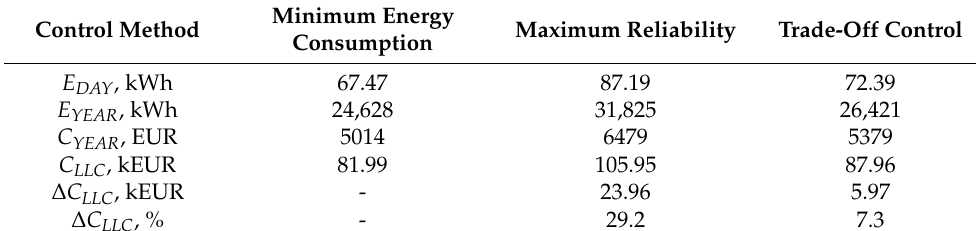
Table 8. Results of the life cycle costs for various considered